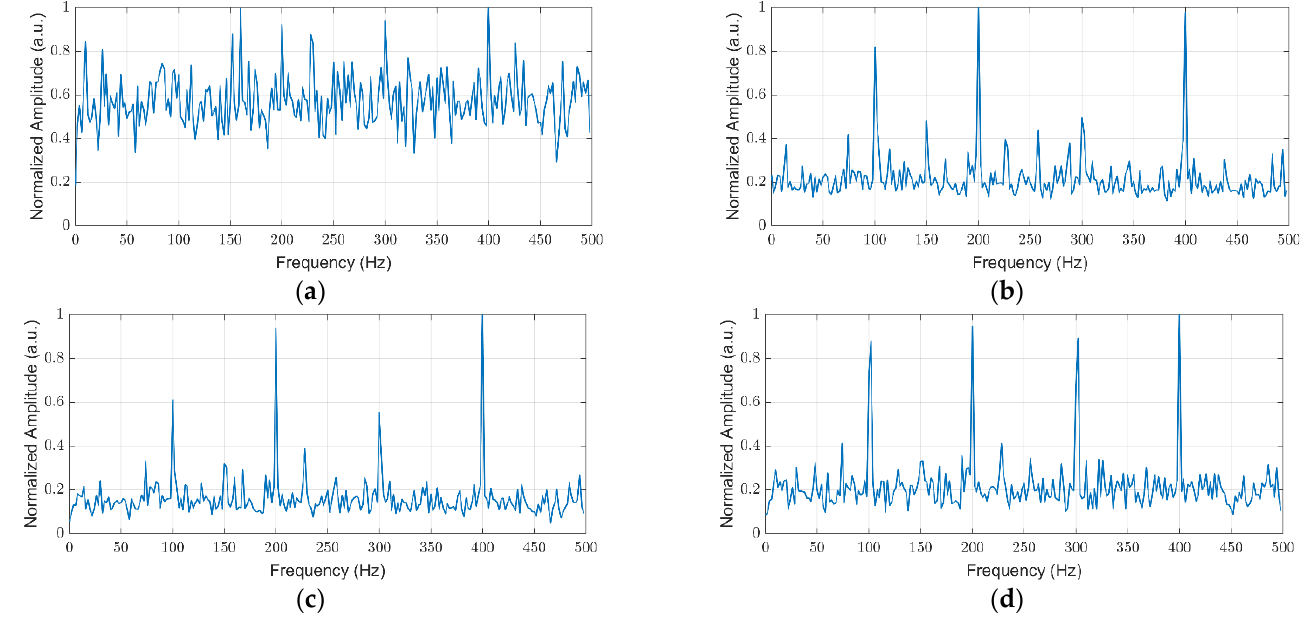
Figure 3. Detecting the four tonal signals in WGN: ( a ) AVGPR; ( b ) CGLRT; ( c ) CAPSE; ( d ) FJ_CAVGPR. Next, the probability of detection ( P D ) versus SNR curves that indicates the minimal input SNR required to reach the given P D for a fixed probability of false alarm ( P FA ) is used to evaluate the detection performance of the four detectors. P D versus SNR curves for | ∆ | = 0 and | ∆ | = 0.5 at P FA = 10 − 2 is obtained from 10, 000 Monte Carlo trials,